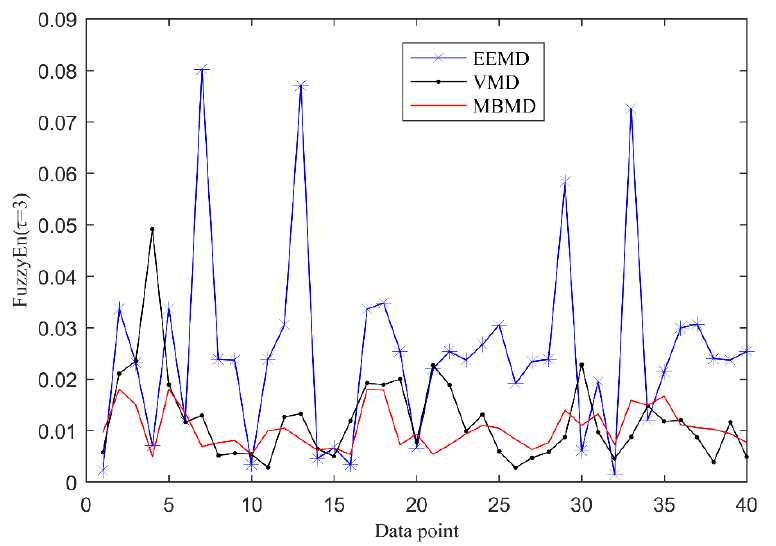
Figure 25. MBMD, VMD, EEMD comparison diagram of the harmonic signal plus the square wave signal.